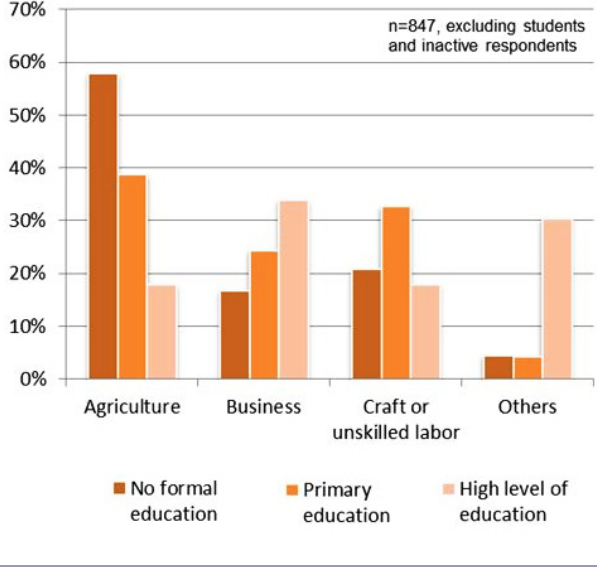
Fig. 2. Main economic activities according to the education level of